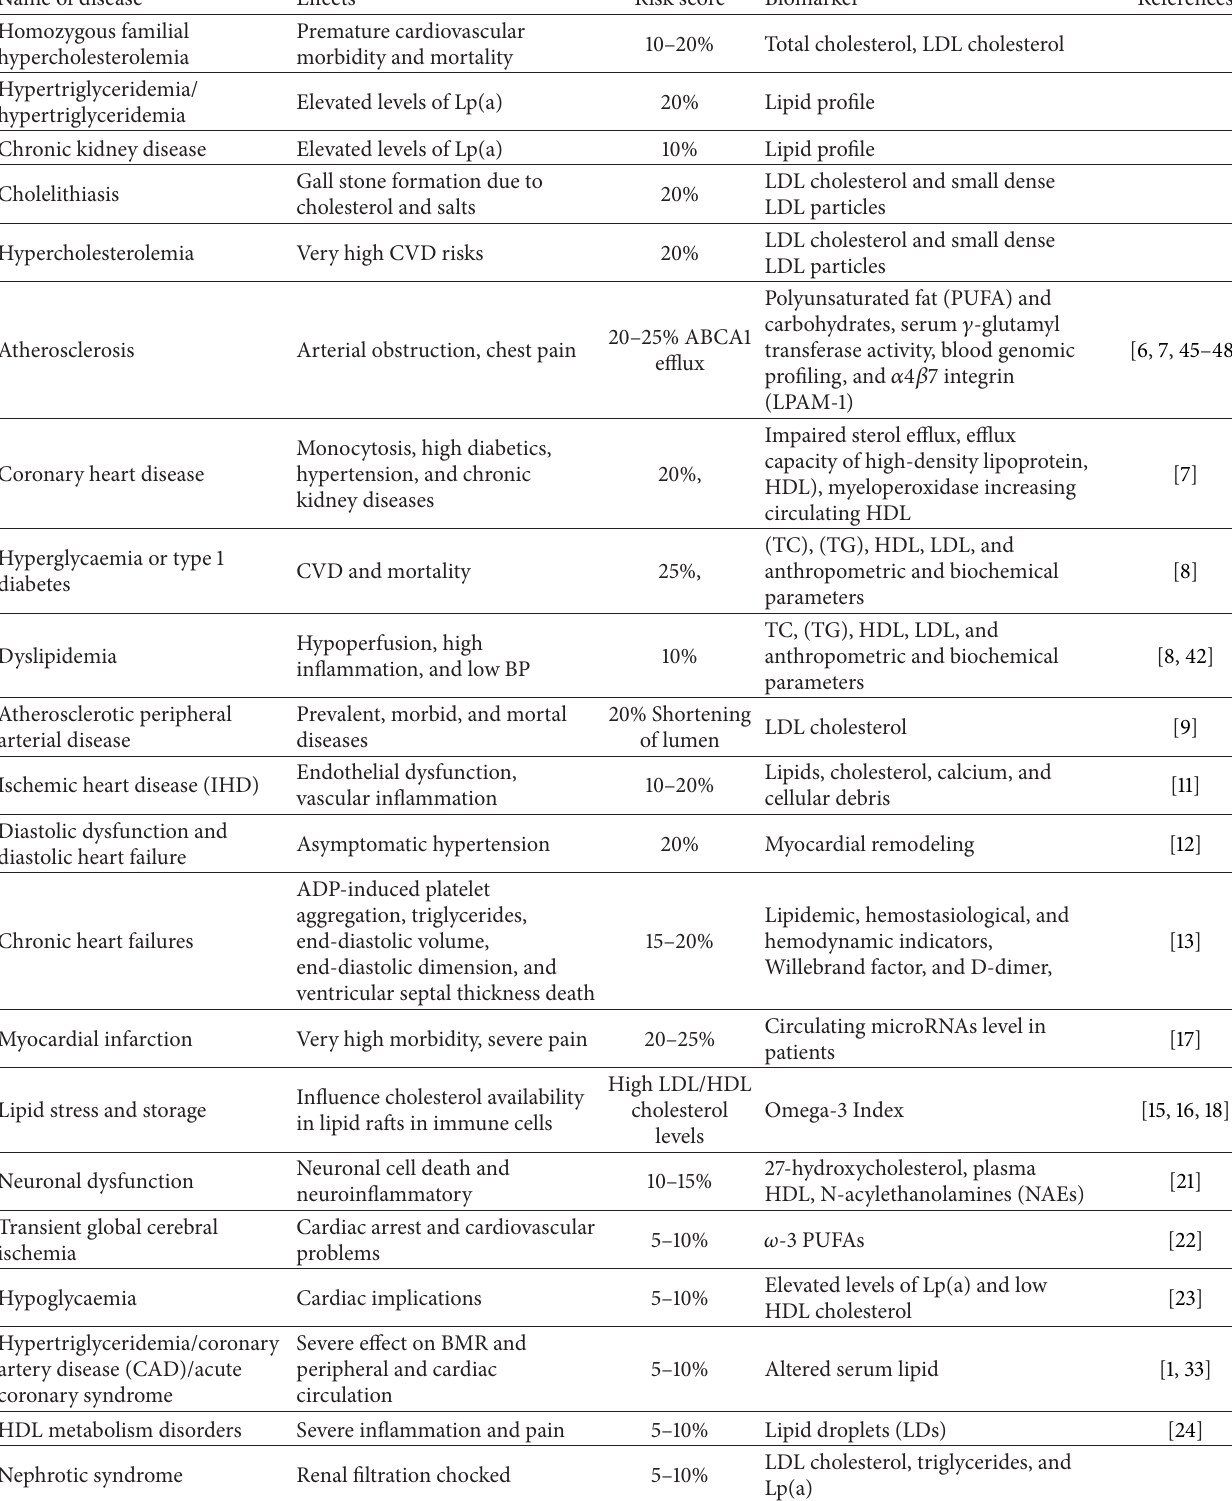
Table 1: Important emerging risk biomarkers in cardiovascular disease and